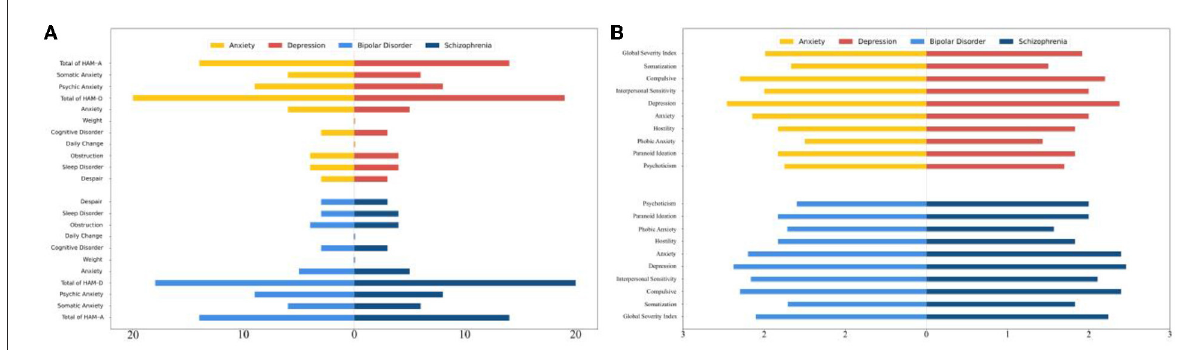
FIGURE2 Subscale scores in each diagnostic group. (A) Subscale scores and total score of HAM-A and HAM-D in each diagnostic group. (B) Subscale scores and total score of SCL-90 in each diagnostic group. HAM-A, Hamilton Anxiety Rating Scale; HAM-D, Hamilton Depression Rating Scale; SCL-90, Symptom